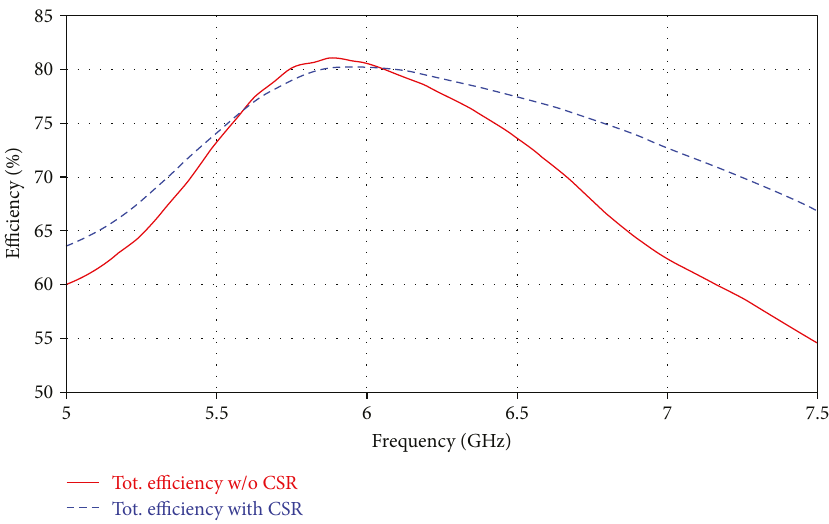
Figure 13: Simulated total e ffi ciency of whole antenna system with and without MTM-CSR matrix structure.